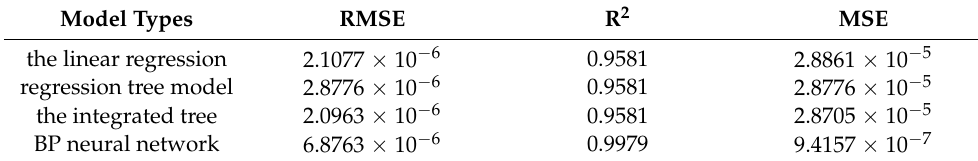
Table 4. Measuring point 1 ( x -axis) regression model evaluation